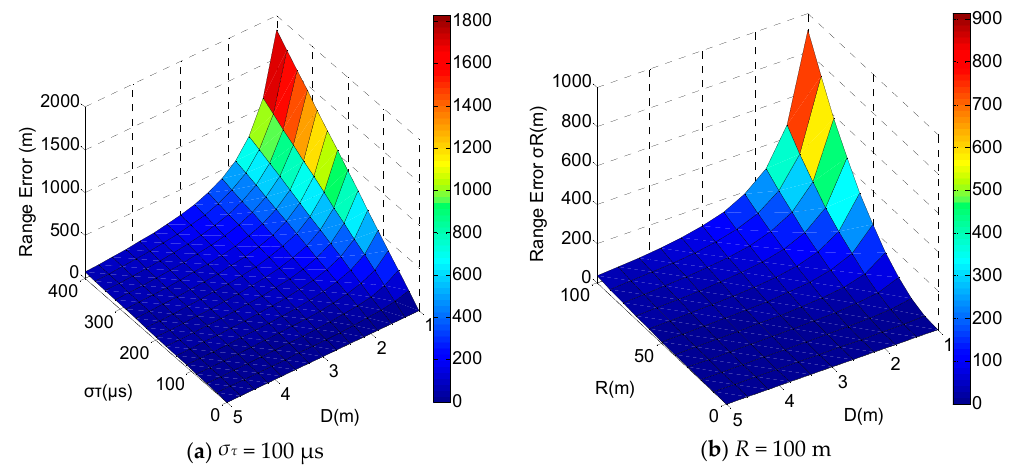
Figure 3. Distributions of the range error of R and σ τ .